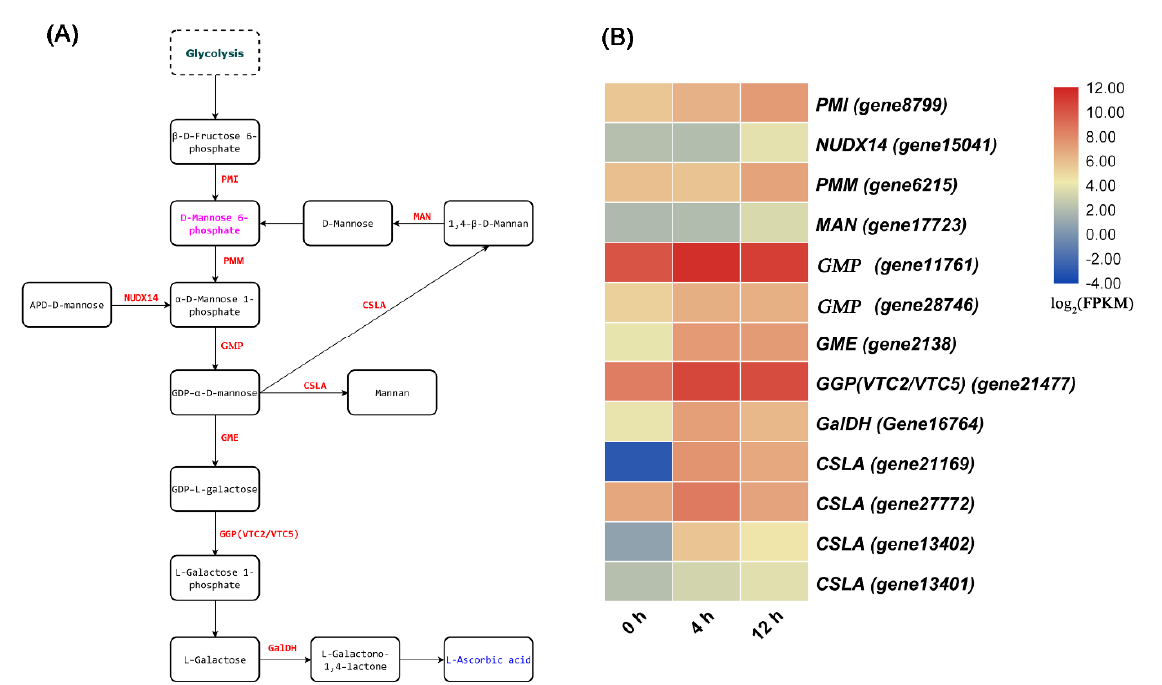
Figure 6. The ascorbic acid biosynthesis pathway and related upregulated genes under salt treatment. ( A ) The ascorbic acid biosynthesis pathway. ( B ) Heat map analysis of upregulated gene expression under salt treatment.